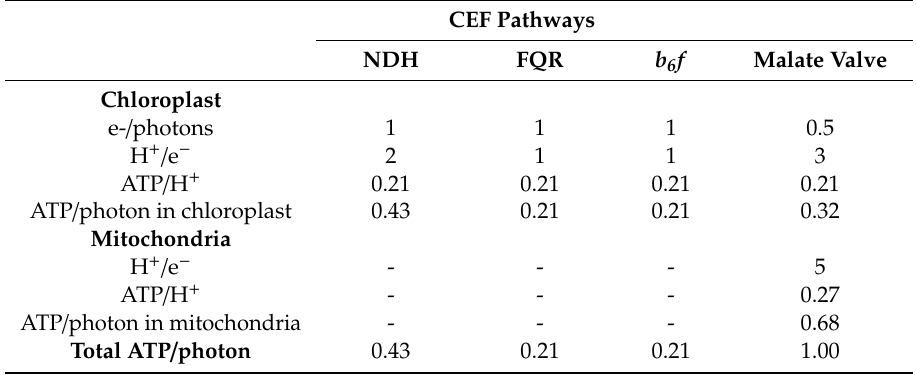
Table 2. Energy requirements and e ffi ciencies of CEF pathways and the malate valve to produce supplemental ATP. Shown are the number of absorbed photons used for the calculation of each pathway. Further details and assumptions for calculations are found in the